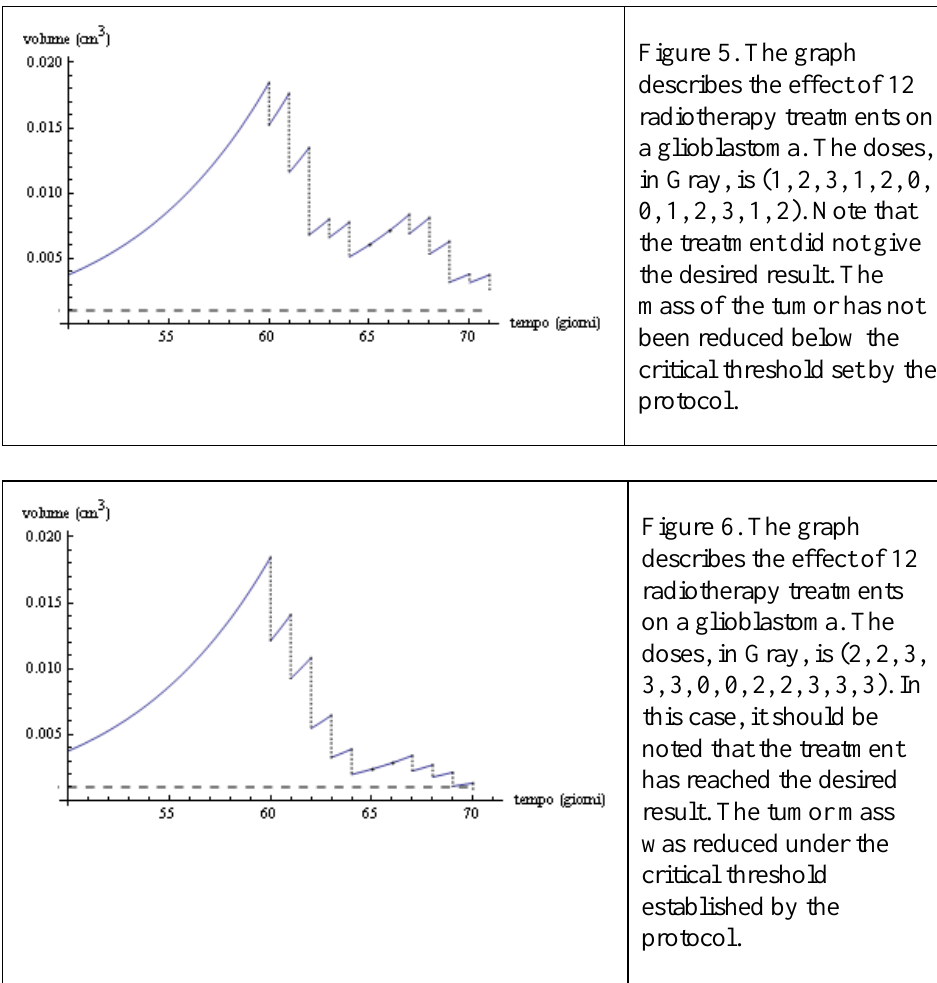
Figure 5. The graph describes the effect of 12 radiotherapy treatments on a glioblastoma. The doses, in Gray, is (1, 2, 3, 1, 2, 0, 0, 1, 2, 3, 1, 2). Note that the treatment did not give the desired result. The mass of the tumor has not been reduced below the critical threshold set by the protocol.